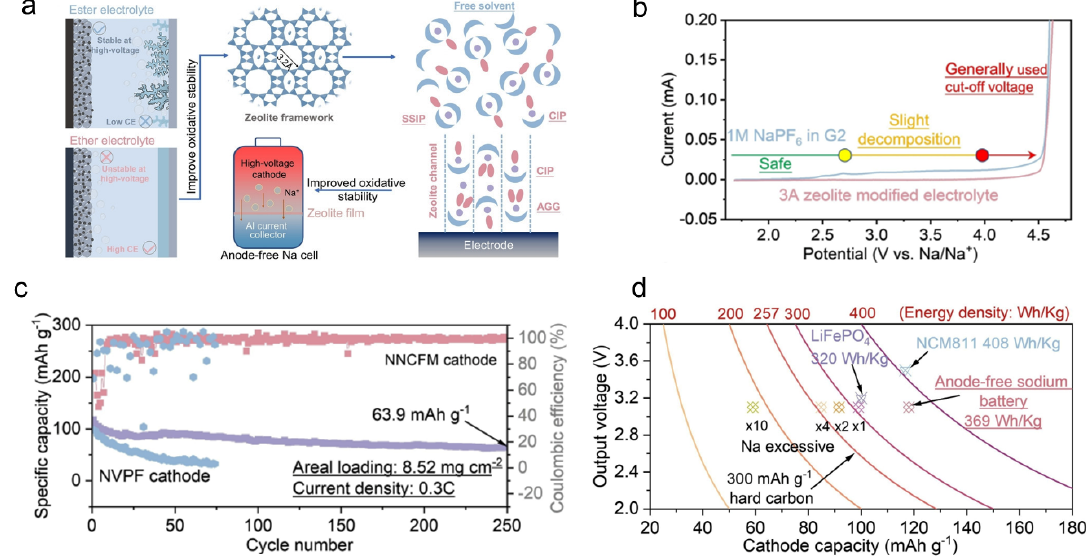
Figure 3. The high-voltage AFSMBs and the corresponding performances. ( a ) The high-voltage AFSMBs constructed by the high-voltage cathode and the zeolite-optimized electrolyte; ( b ) the oxidative stability test by the LSV with a generally used cut − off voltage at 4.5 V. The compared electrolytes are pristine 1 M NaPF 6 − G2 electrolytes and 3A zeolite − modified electrolyte; ( c ) the cycling performances of the Na 3 V 2 (PO 4 ) 2 F 3 /Al and NNCFM/Al cells; ( d ) the comparison of the energy density with different Na excessive cells, traditional LIBs, and the AFSMBs [26] . Reproduced with the permission of ref. [26], copyright 2022 Wiley − VCH Verlag GmbH & Co. KGaA, Weinheim.